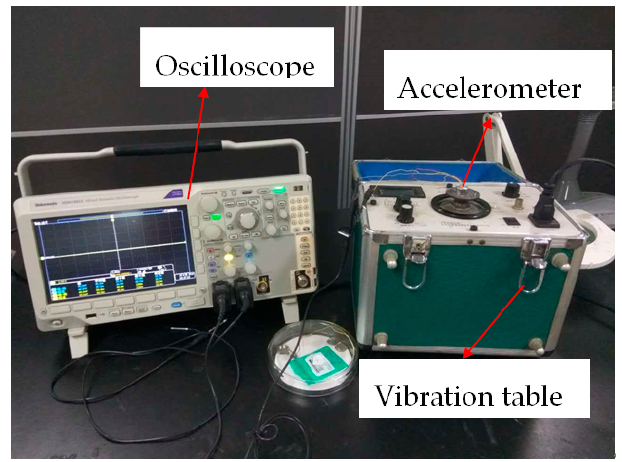
Figure 15. Vibration test.